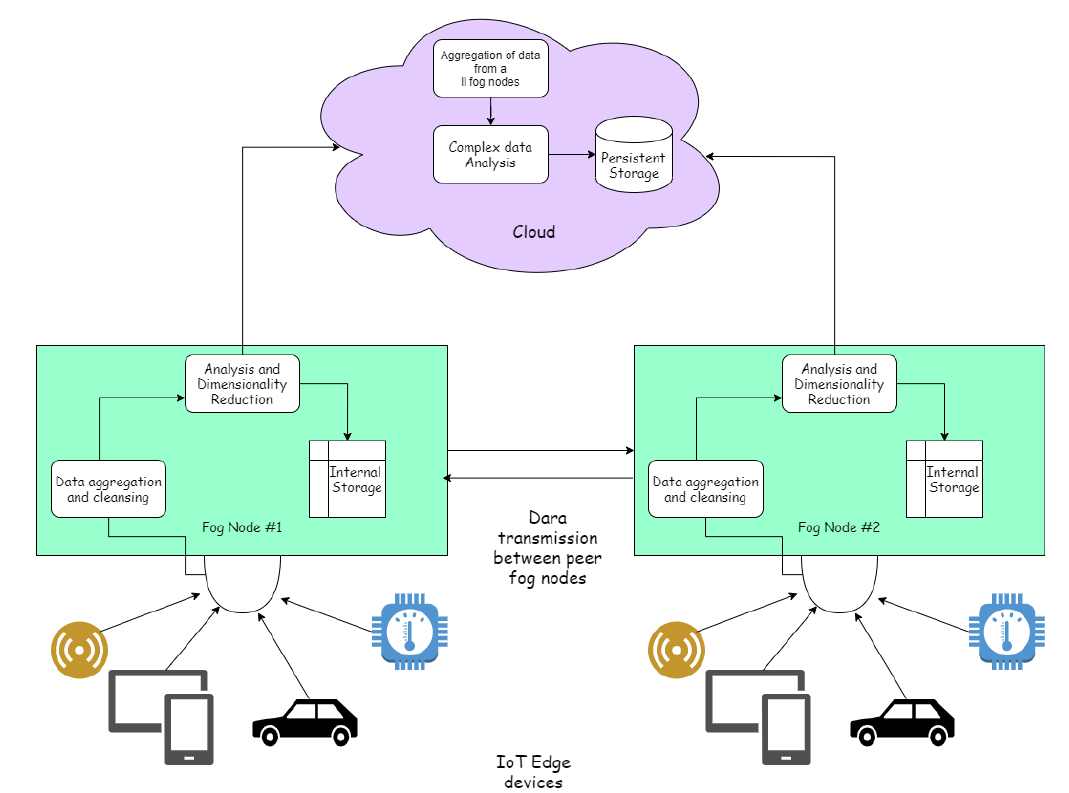
Figure 6. Data analytics using fog